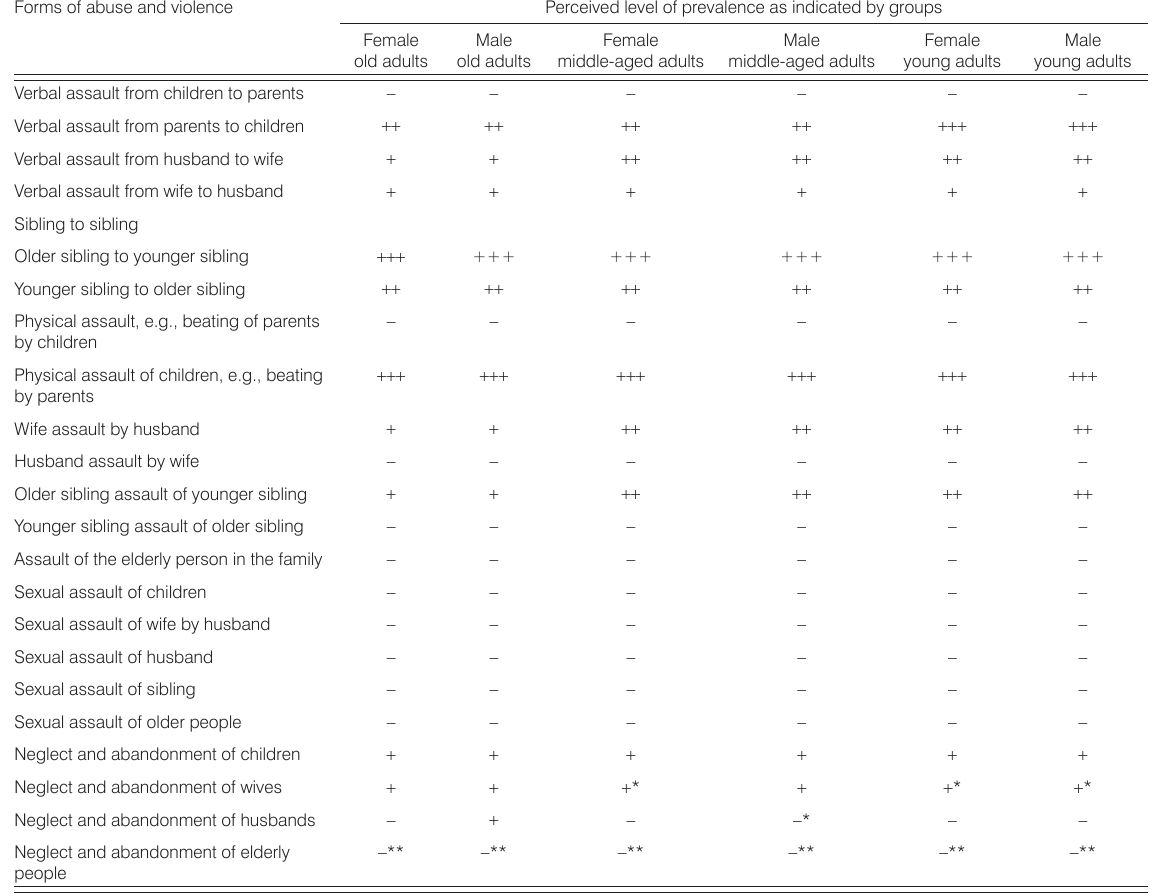
Table 2. Views about how common identified forms of violence among the Yoruba people by groups. away” for the child to know that the act performed is